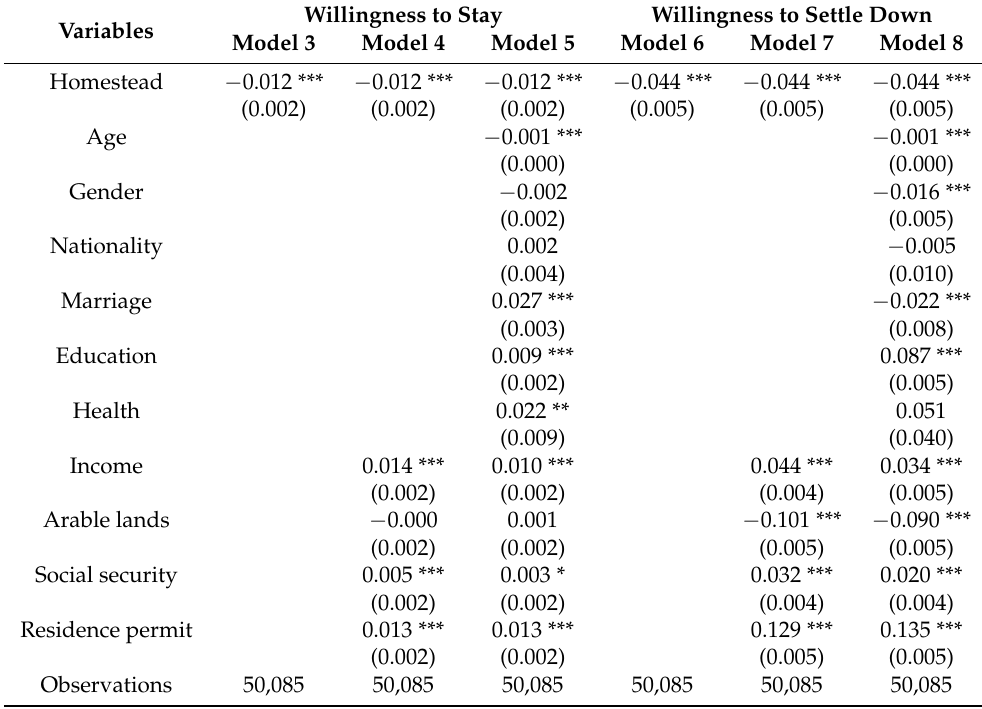
Table 4. Stepwise regression results (average marginal